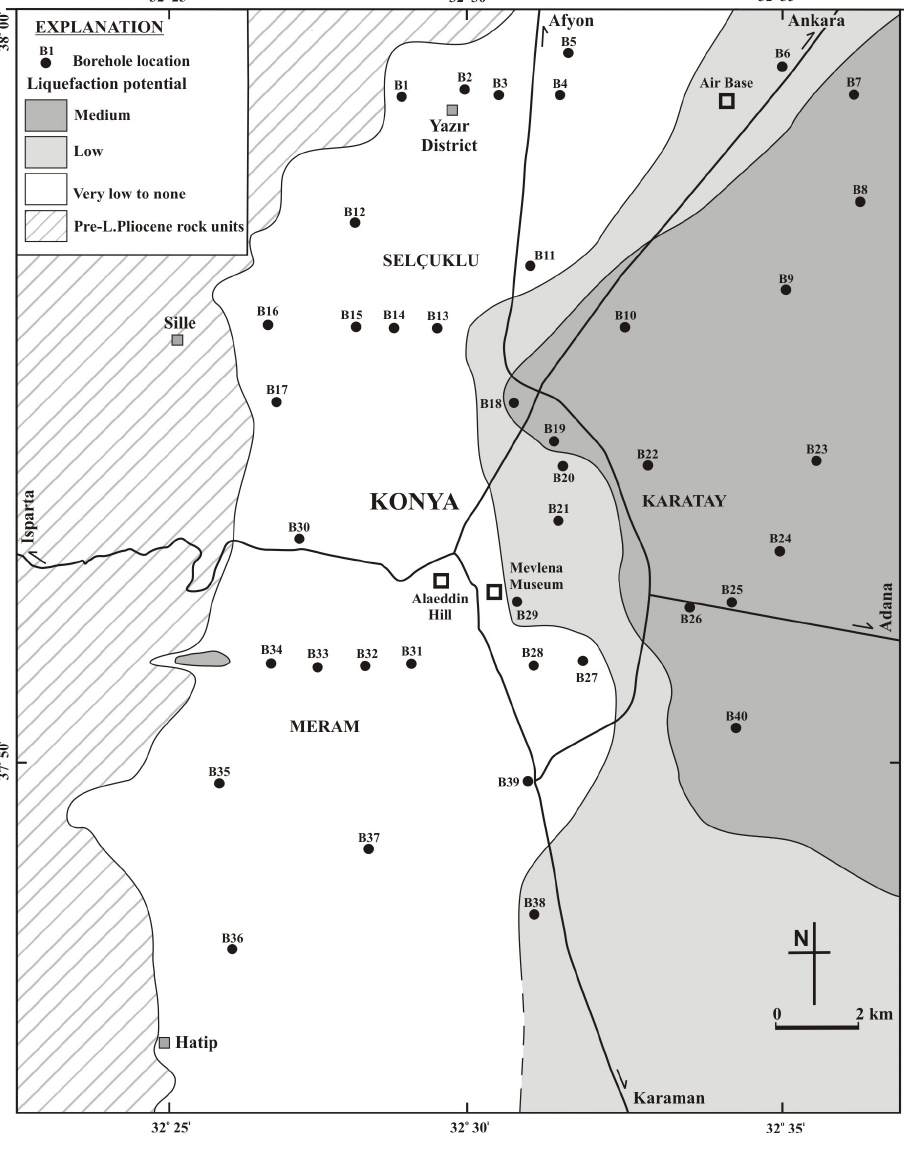
Fig. 5. Liquefaction potential map of the Konya